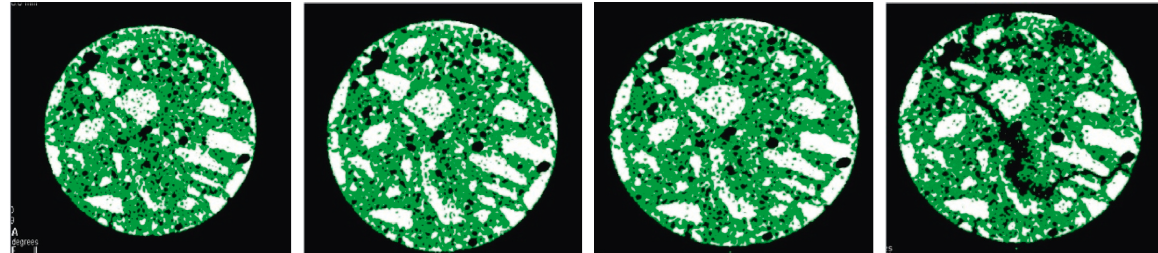
Figure 16: The CT isodensity segmentation maps under different dynamic tensile loading.